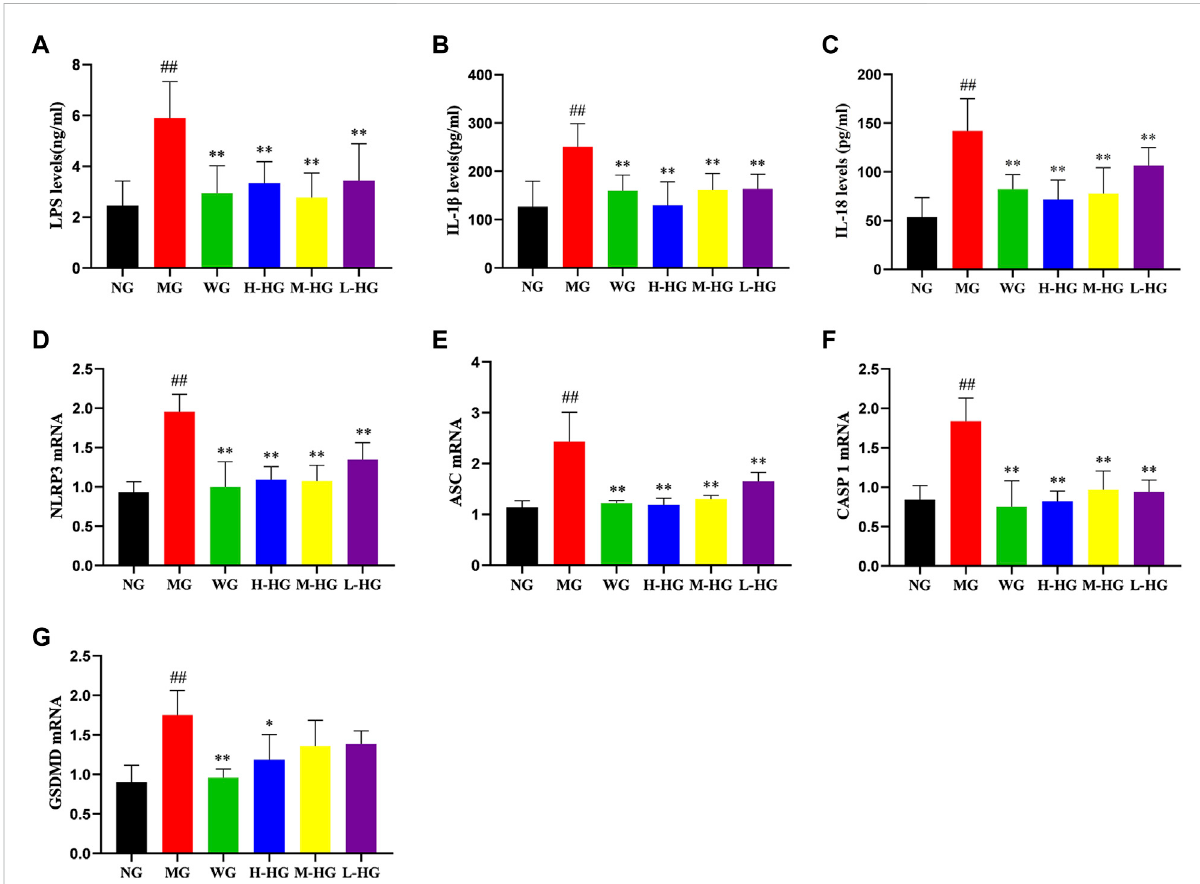
FIGURE 8 HZJDDrestrainedtheNLRP3/caspase-1pathwayofDSS-inducedUCinrats.ThelevelsofLPS (A) ,IL-1 β (B) ,andIL-18 (C) (n=10)andthemRNA expressionofNLRP3 (D) ,ASC (E) ,caspase-1 (F) ,andGSDMD (G) (n=3)ineachgroup.Dataarepresentedasthemean±SD. ## p < 0.01or # p < 0.05vs NG, ** p < 0.01 or * p < 0.05 vs